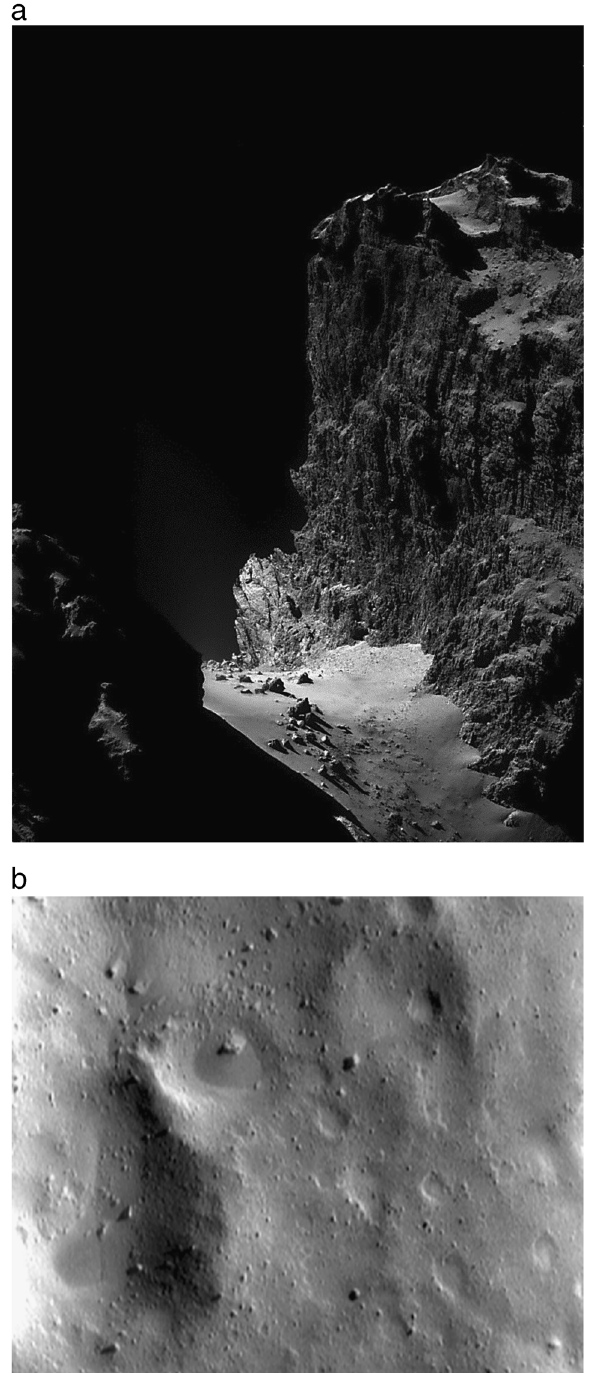
Fig. 1 Silicate and icy regolith in milligravity conditions. a A 1-km cliff on the 4 km diameter comet 67P/Churyumov – Gerasimenko imaged early in the ESA Rosetta mission (12/2014). Four-panel NAVCAM mosaic acquired from 20km radius about the comet center. Surface gravity g~0.1 cm s − 2 , so a leaping astronaut would land a half hour later at ~1m s − 1 , either into soft materials or a solid icy crust. Boulders at the cliff base are up to tens of meters diameter. Material is a combination of ices and amorphous volatiles and silicates